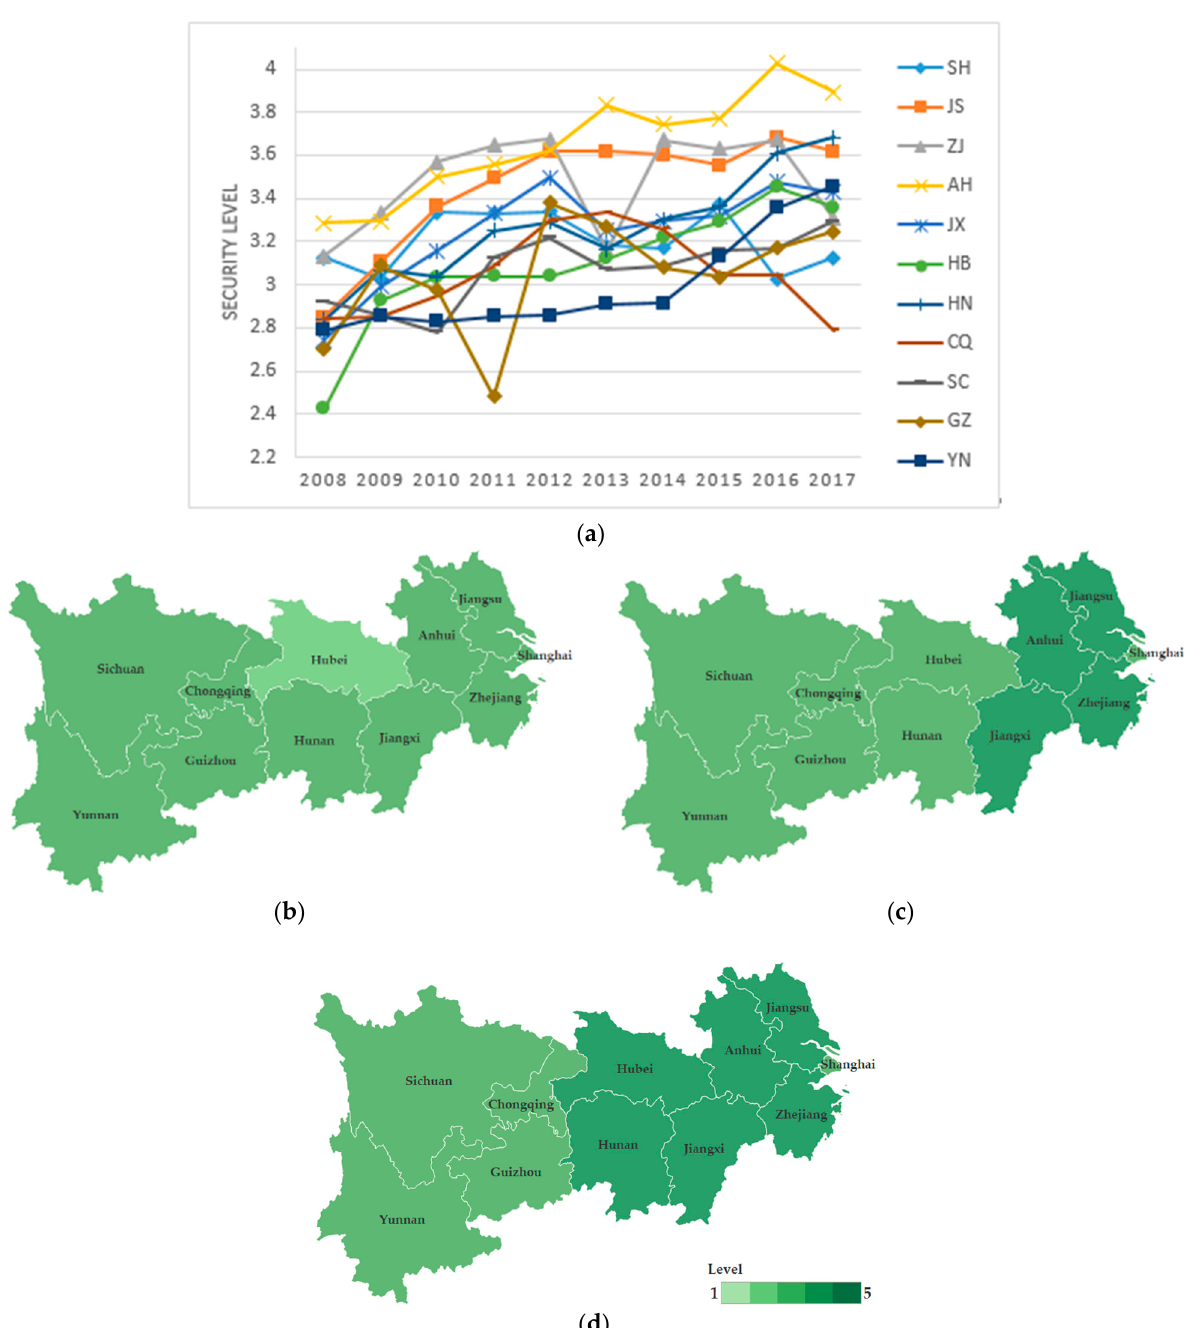
Figure 7. Food subsystem evaluation results: ( a ) Trend graph of food subsystem security of each province (municipality) in the Yangtze River Economic Belt during 2008–2017; ( b ) Distribution of food security in 2008; ( c ) Distribution of food security in 2012; ( d ) Distribution of food security in 2016.